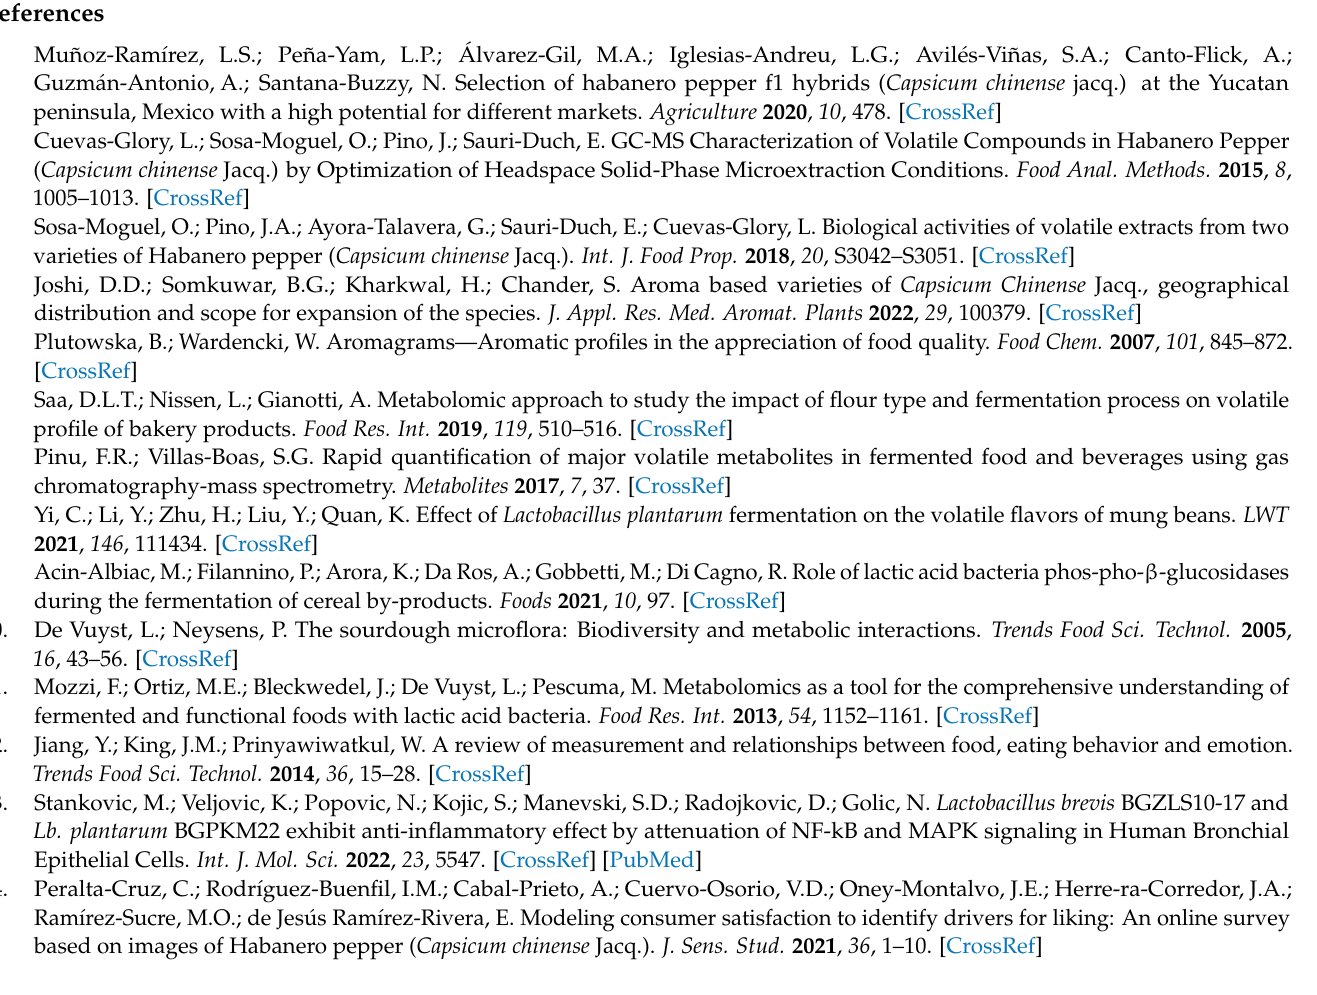
Figure A3. Chromatogram of the sample COM 72 h.